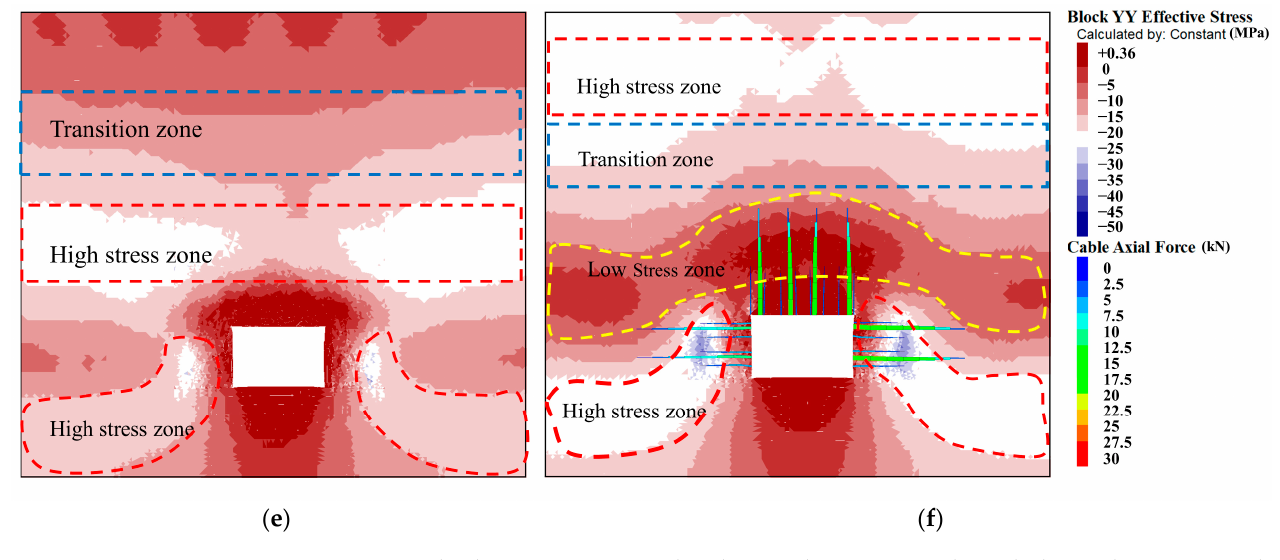
Figure 10. Shock wave YY − stress distribution characteristics through the roadway-surrounding rock. ( a ) The shock wave reaches the roadway roof (no support). ( b ) The shock wave reaches the roadway roof. ( c ) The shock wave reaches the two ribs of the roadway (no support). ( d ) The shock wave reaches the two ribs of the roadway ( e ) The shock wave reaches the floor of the roadway (no support) ( f ) The shock wave reaches the fl oor of the roadway.